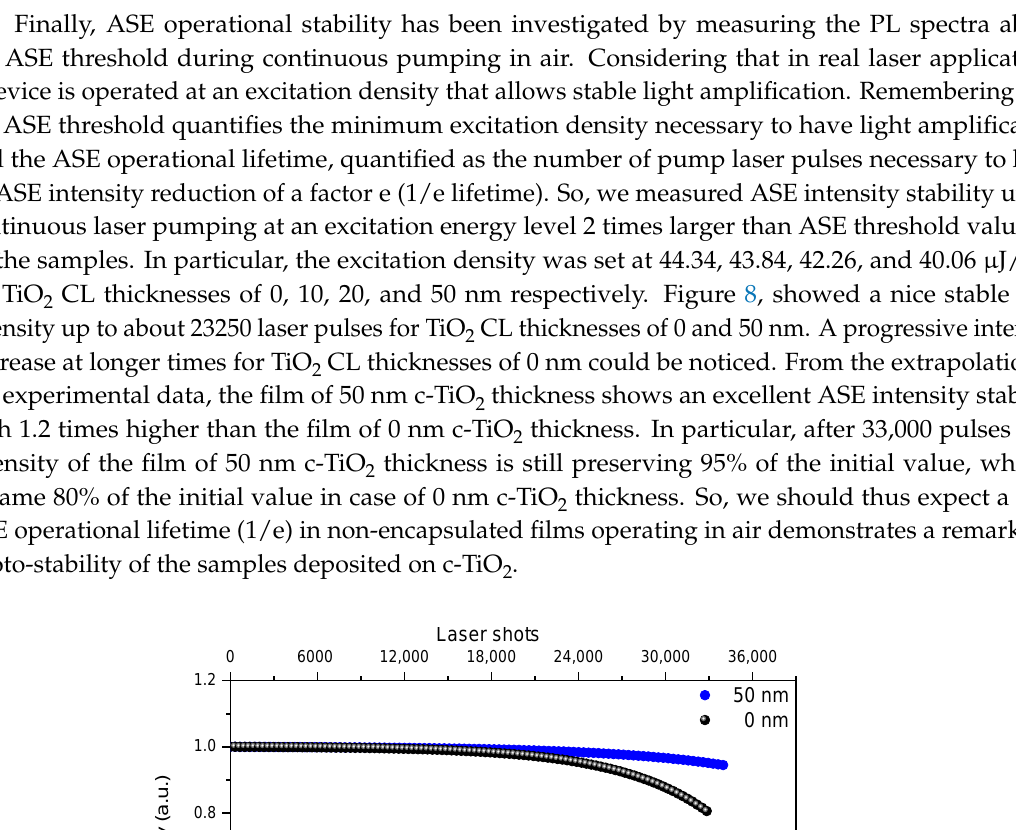
Figure 7. PL versus excited carrier density of the pure PQDs CsPbBr 3 and CsPbBr 3 PQDs/c-TiO 2 films for 0, 10, 20, and 50 nm c-TiO 2 thickness respectively.